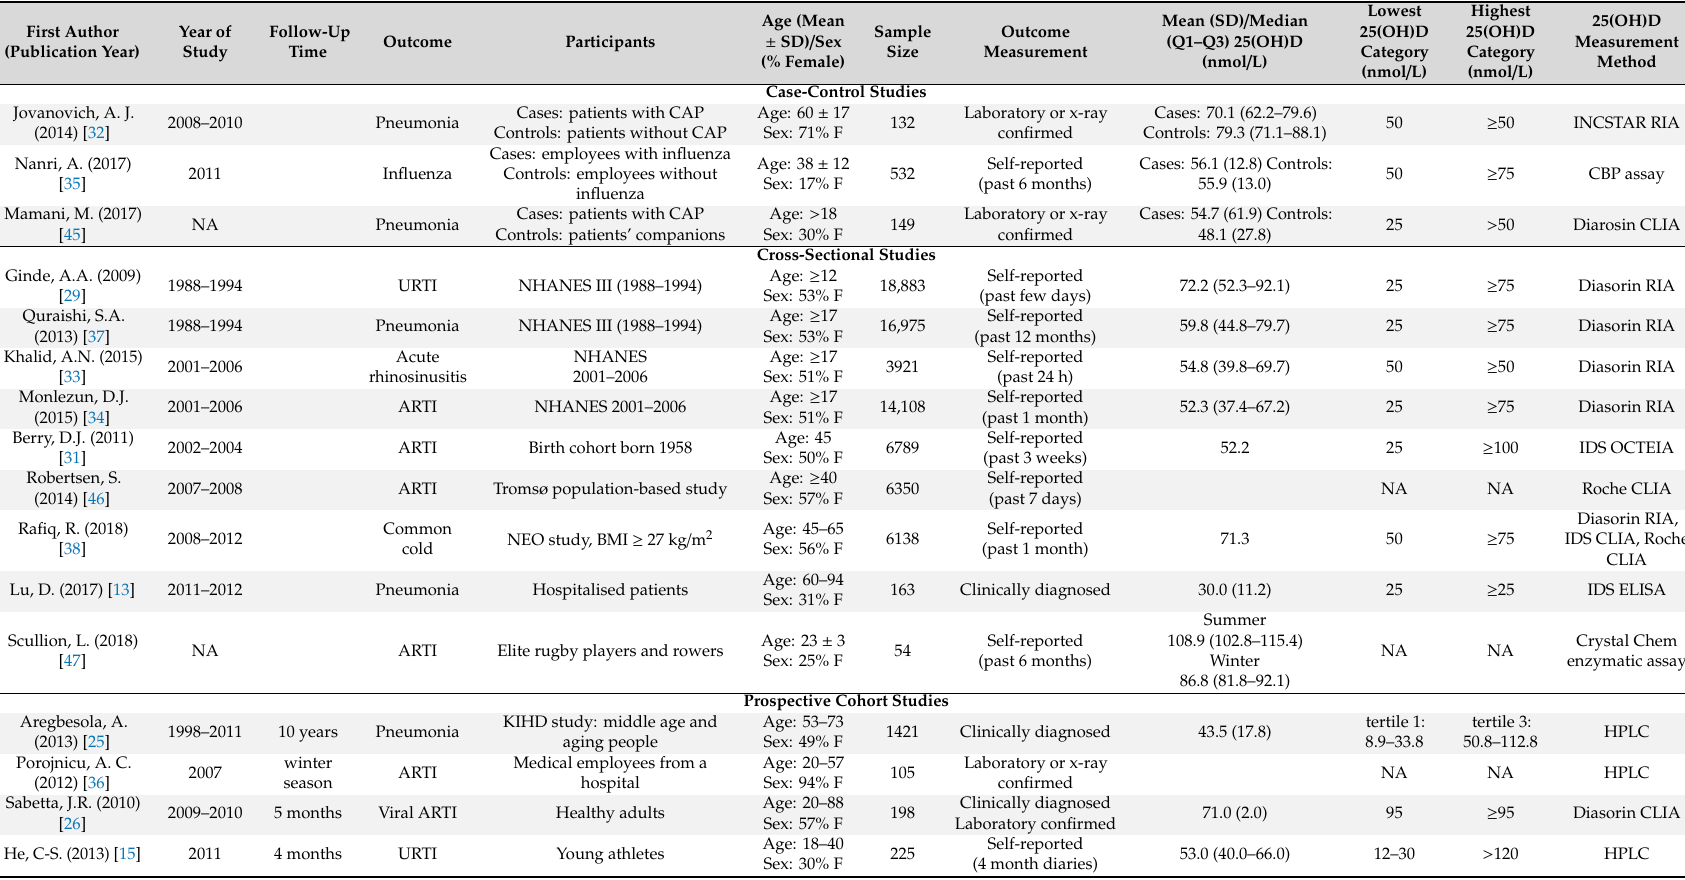
Abbreviations: ARTI = acute respiratory tract infection; CAP = community acquired pneumonia; CBP = competitive protein binding; KIHD = Kuopio Ischemic Heart Disease Risk Factor; IDS = Immunodiagnostic Systems; RIA = radioimmunoassay; CLIA = chemiluminescence immunoassay; HPLC = high performance liquid chromatography; LRTI = lower respiratory tract infection; MS = mass spectrometry; NA = not available; NEO = Netherlands Epidemiology of Obesity study; NHANES = National Health and Nutrition Examination Survey; URTI = upper respiratory tract